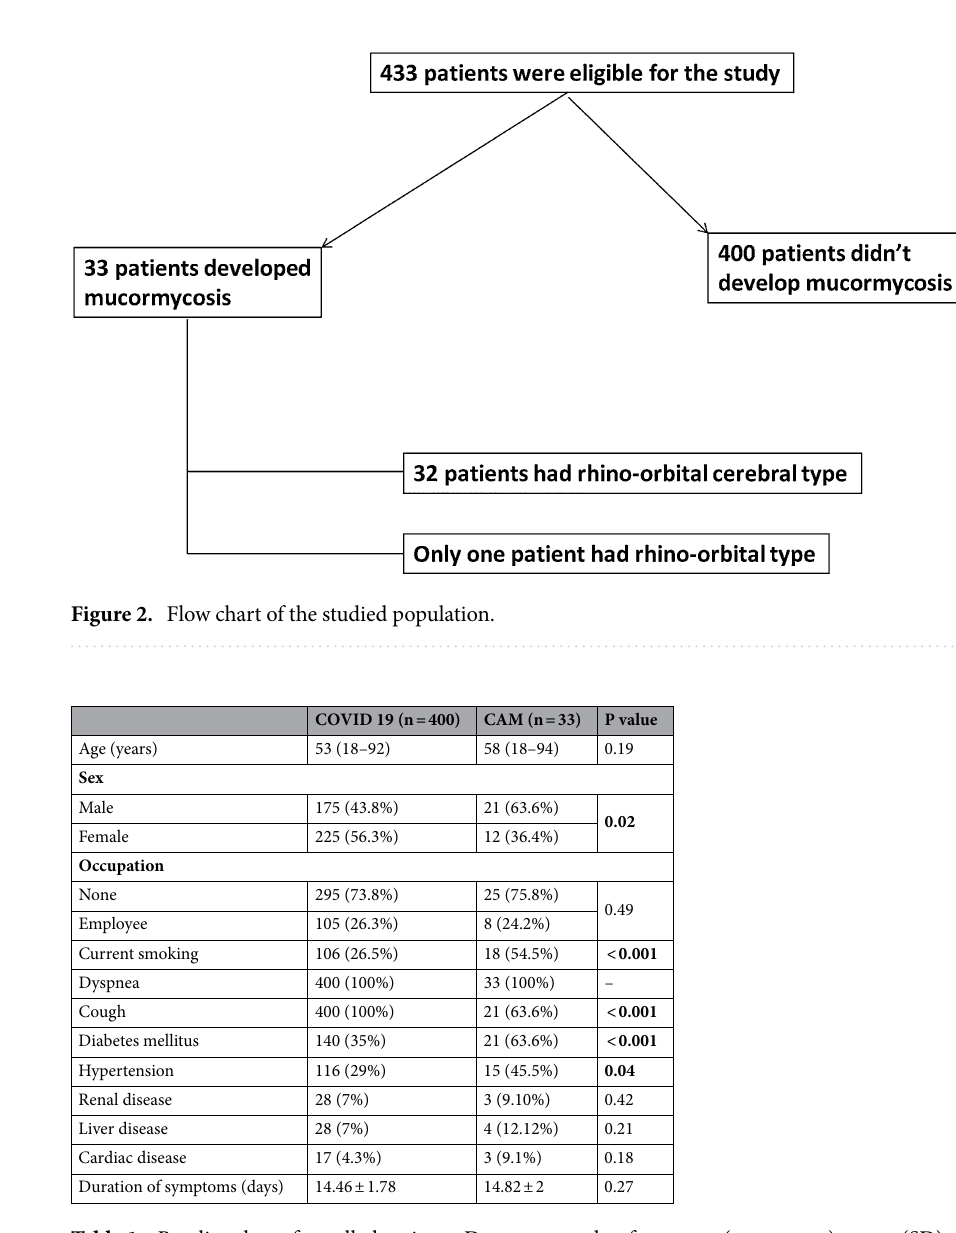
Table 1. Baseline data of enrolled patients: Data expressed as frequency (percentage), mean (SD). P value was significant if < 0.05. Nominal data was compared by Chi-square test while age was compared by Mann Whitney test while duration of symptoms was compared by Student t test. CAM: covid associated mucormycosis. Significant values are given in